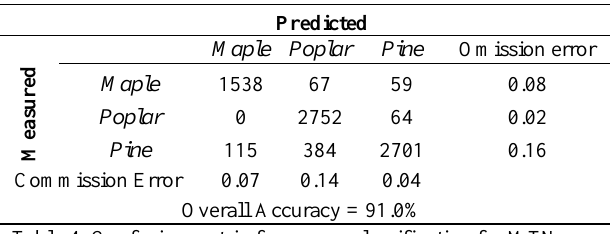
Table 4. Confusion matrix for genera classification for MTN